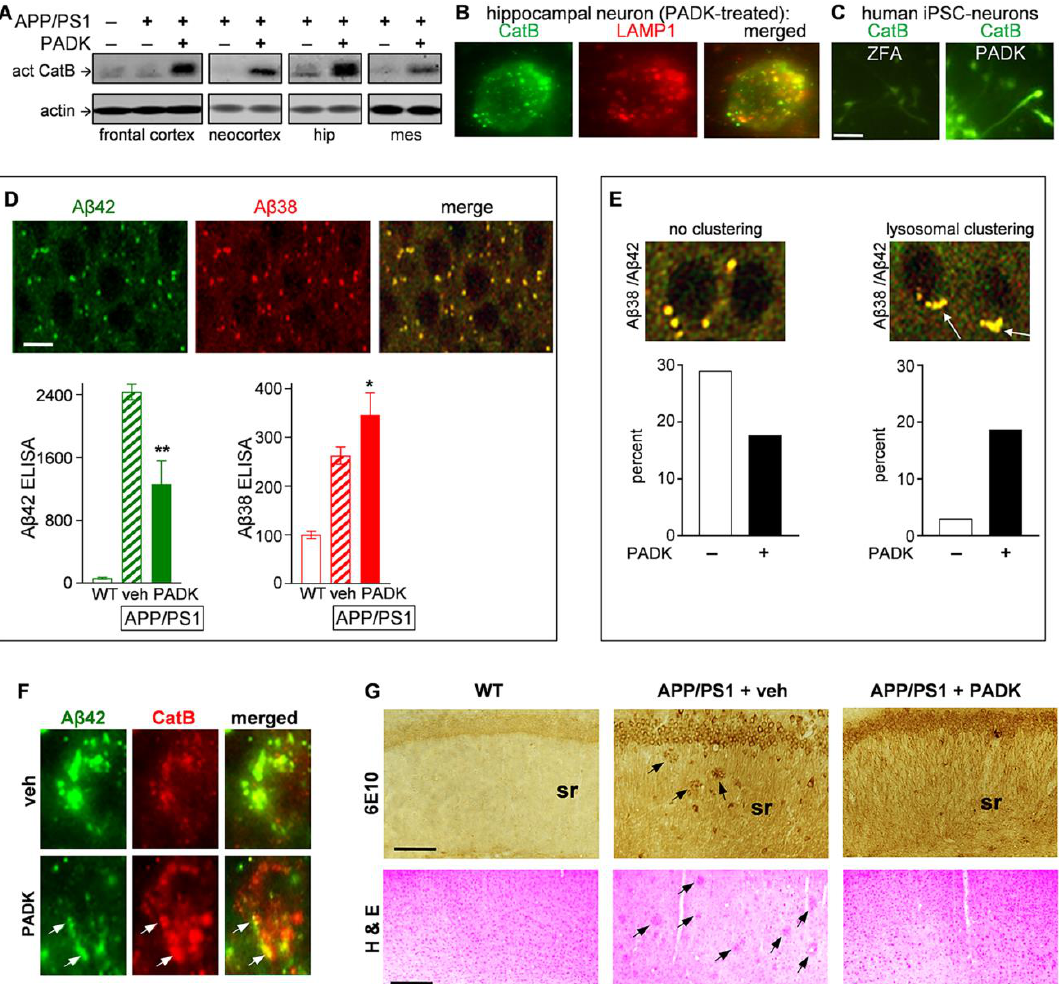
Figure 2. Enhancement of cathepsin B (CatB) promotes a lysosomal pathway for Aβ42 detoxification and clearance. Equal protein aliquots of homogenates from vehicle ( − ) and Z-Phe-Ala-diazomethylketone (PADK)-treated APP/PS1 mice (+) in cropped immunoblots were assessed for the 30-kDa active CatB isoform alongside wild-type controls ( A ) (also see immunoblots in Supplementary Materials). hip, hippocampus; mes, mesencephalon. Neurons in PADK-treated mice were double-labeled for CatB (green) and LAMP1 (red); an example is shown with lysosomal localization of the modulated CatB ( B ; view-field width: 15 µm). Cultures of human induced pluripotent stem cell (iPSC)-derived neurons were treated for three days with 5 μM inactive Z-Phe-Ala-OH (ZFA) compound or with PADK, followed by fixation and CatB staining ( C ; size bar: 50 µm). APP/PS1 hippocampal tissue was double-labeled with anti- Aβ42 (green) and anti - Aβ38 antibodies (red), showing striking correspondence in the merged image ( D ; size bar: 10 µm). The two antibodies were also used to quantify the distinct peptides (fmol/mg protein) in samples from the different animal groups with selective sandwich ELISA protocols. Nonparametric Mann – Whitney tests compared to vehicle-treated APP/PS1 data: * p < 0.05, ** p = 0.01. Merged confocal images of anti- Aβ42 and anti - Aβ38 immunostaining ( E ) show representative neurons with no apparent lysosomal clustering (left) vs. neurons with polar accumulation of clustered lysosomes (right). Individual pyramidal neurons from vehicle- ( n = 100) and PADK-treated tissue ( n = 150) were categorized to determine the percentage of neurons with no clustering (left graph) vs. the percentage with clustering of multiple lysosomes (right graph). χ 2 analysis of categorical distributions: χ 2 = 27.1, p < 0.0001. The vehicle- and PADK-treated tissue was also double-labeled to assess the increase in organellar CatB (red) and associated decrease in anti- Aβ42 staining (green) within pyramidal neurons ( F ), with arrows denoting colocalization found in clustered organelles exhibiting polar distribution (view-field: 15 µm). Hippocampal